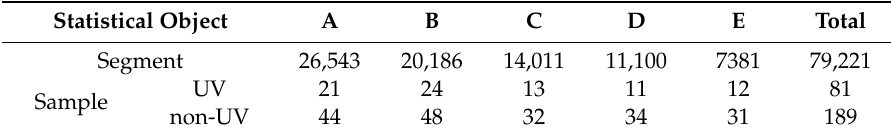
Figure 5. Distribution of UV and non-UV samples in each zone. Table 2. Composition of samples in each zone.